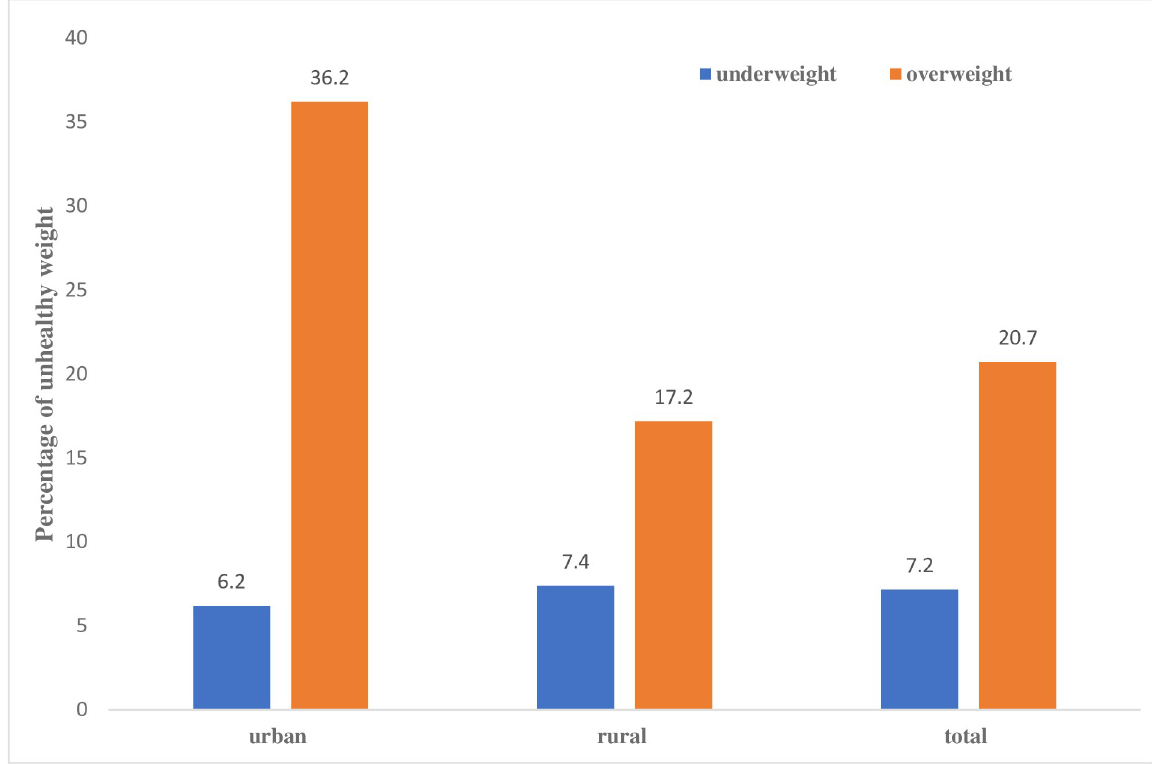
Fig 2. Percentage distribution of unhealthy weight by urban-rural